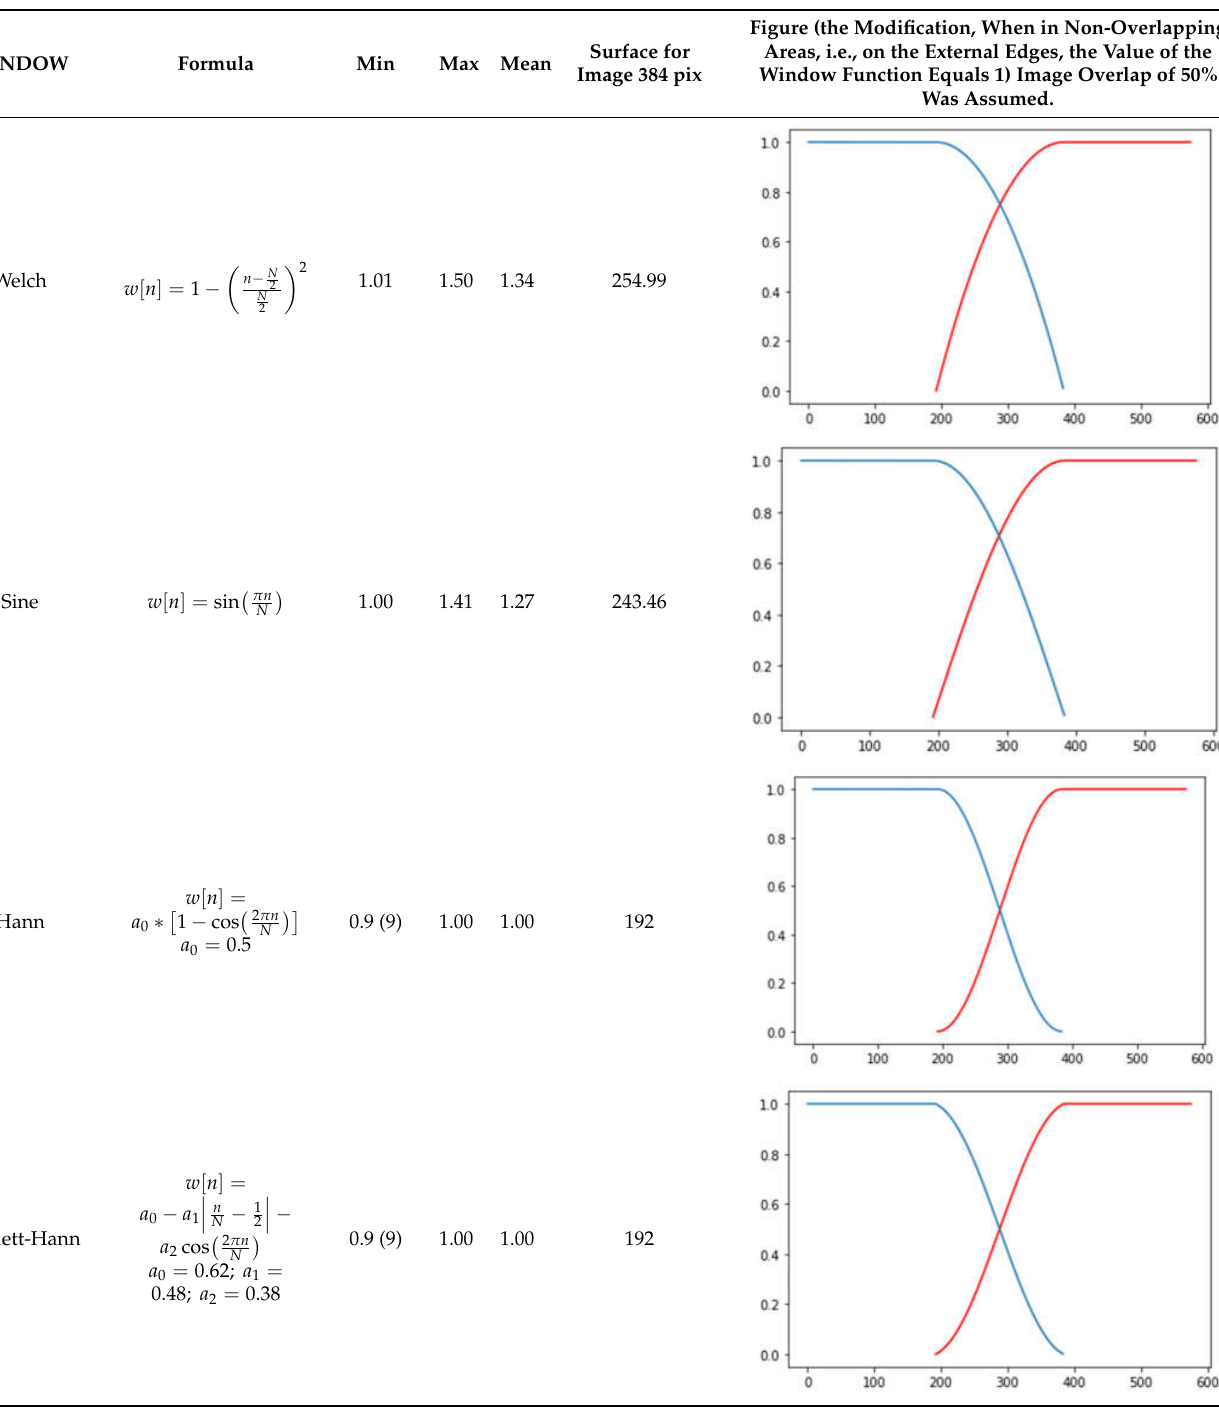
Table A1. Windows formulas that were used for the calculations.